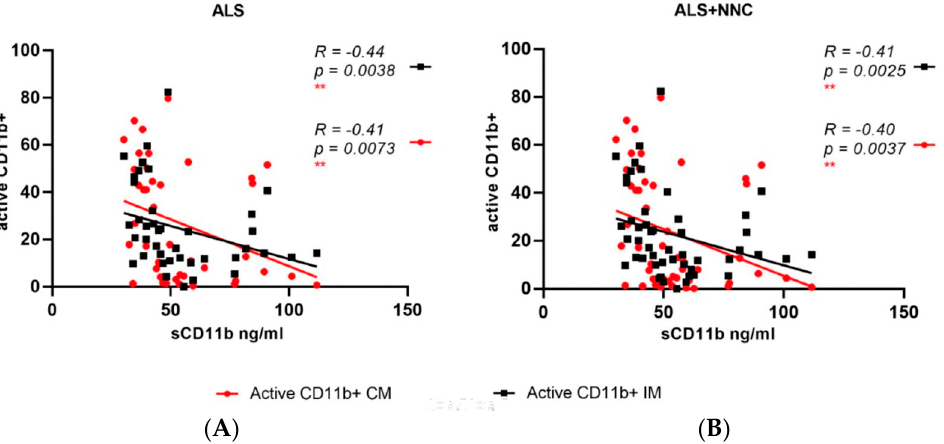
Figure 4. Pairwise correlation analysis between soluble CD11b plasma protein (sCD11b) concen- trations and active CD11b monocytes frequencies in blood. In ALS samples only, sCD11b plasma concentrations are inversely correlated with the frequencies of active CD11b+IM ( R = − 0.44, p = 0.0038) and active CD11b+ CM ( R = − 0.41, p = 0.0043) ( A ). In all samples (ALS + NNC), sCD11b plasma concentrations show an inverse correlation with frequencies of active CD11b+IM ( R = − 0.41, p = 0.0025) and active CD11b+ CM ( R = − 0.40, p = 0.0037) ( B ). Analysis performed without 4 outliers with a sCD11b concentration >400 ng/mL (Supplementary Figure S4 shows a similar level of significance with all samples included).